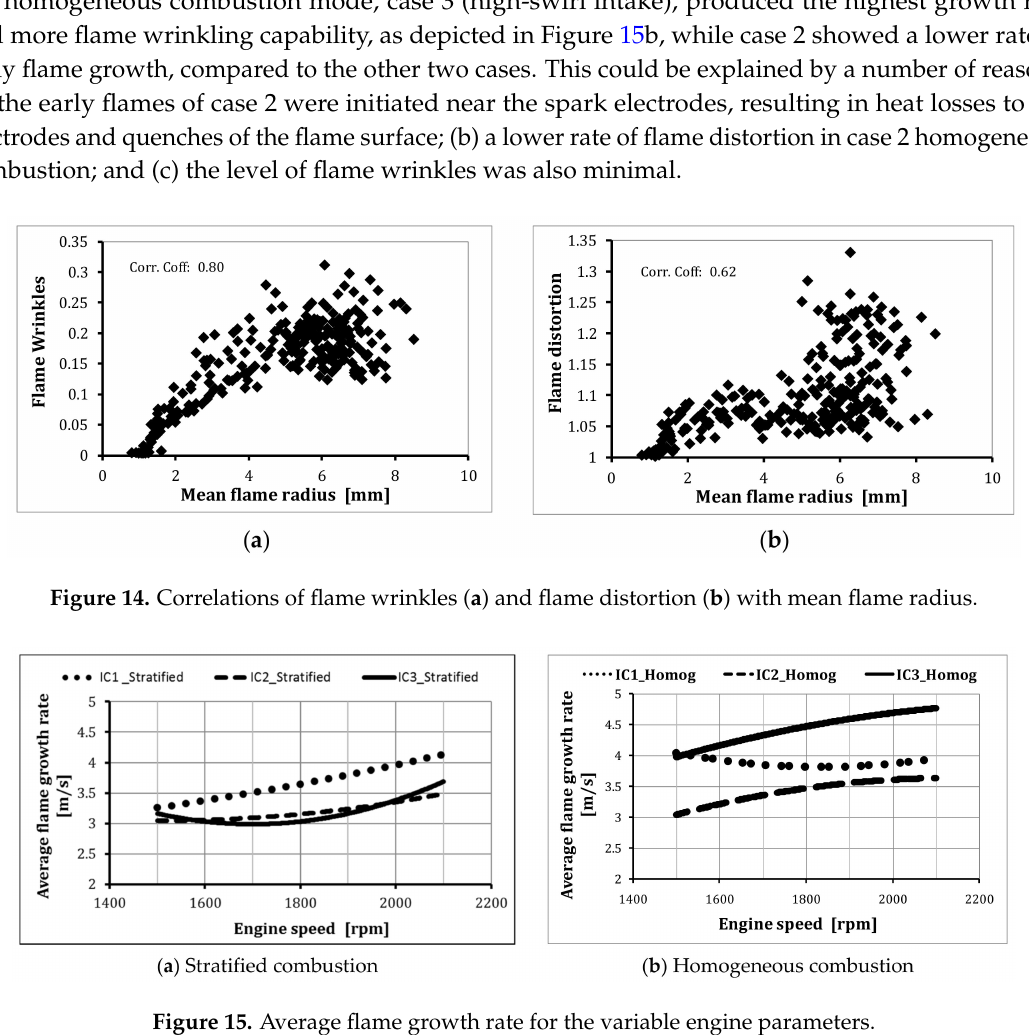
Figure 15. Average flame growth rate for the variable engine